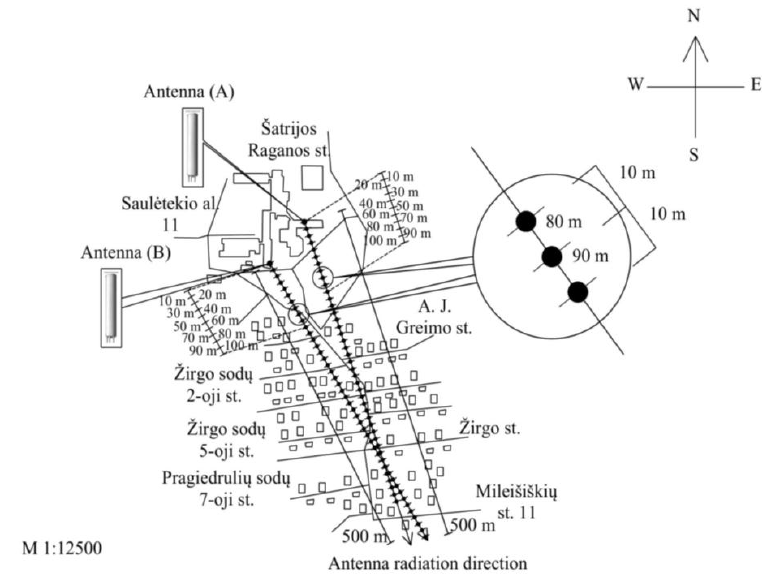
Figure 4. Measurement scheme of the electromagnetic power density of the mobile telephony base station antenna (ERP = 1329 W).